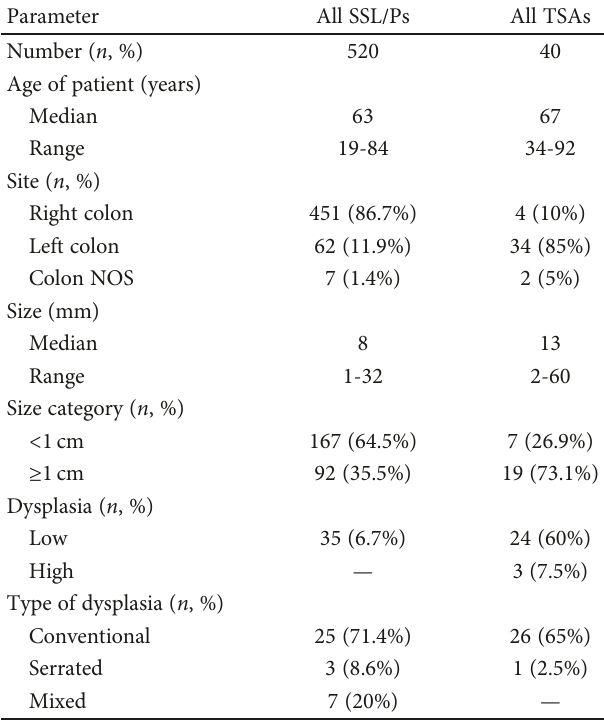
Table 4: Characteristics of TSAs identi fi ed over a 12-year period at our institution; n = 40 .